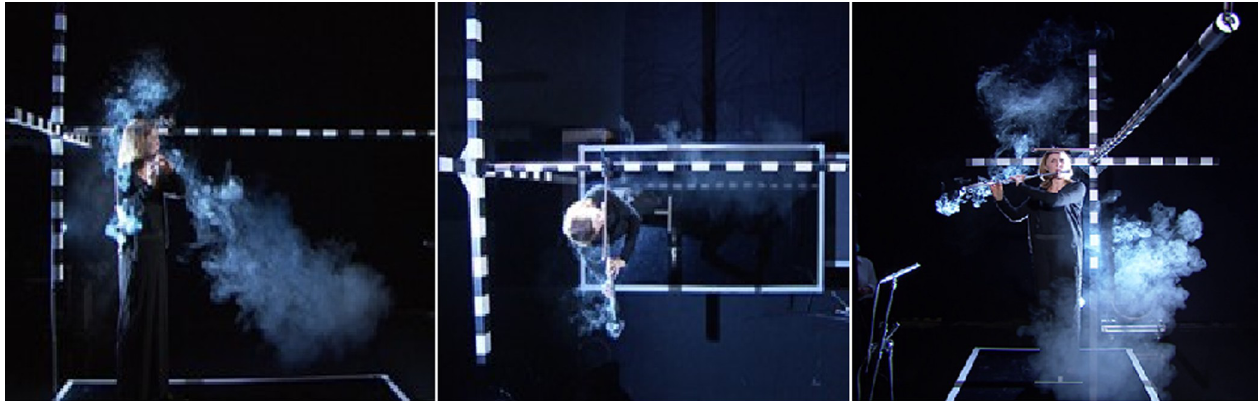
Fig 3. Pictures of a flute player (from left to right) in the side view, top view and front view at the test setup while playing the melody. Three clouds were developed from the flute: at the mouthpiece, at the end of the instrument and from the key plane.